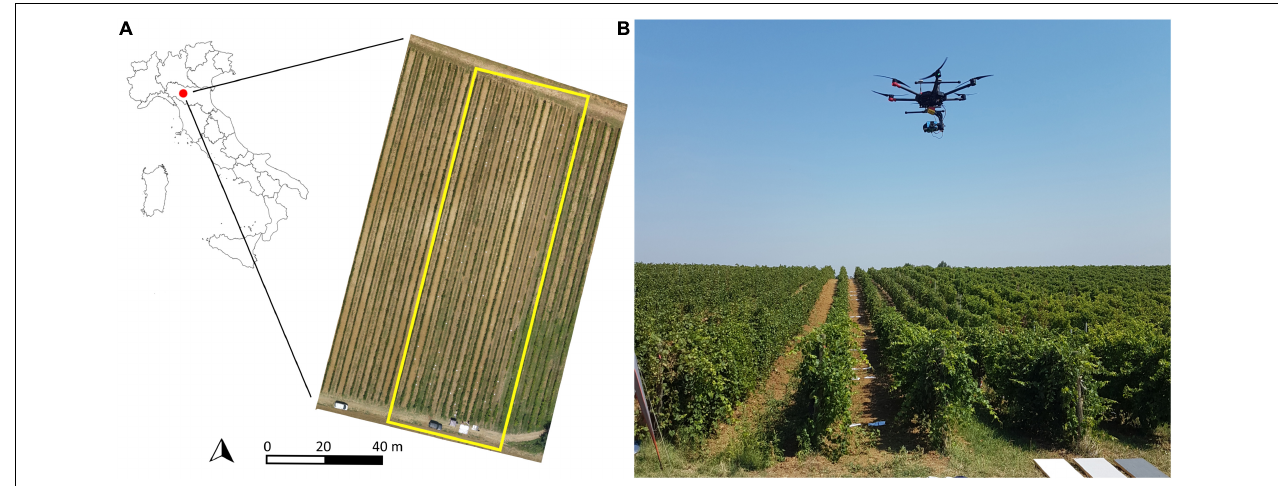
FIGURE 2 | Location of the experimental vineyard (A) and the Unmanned Aerial System used in the study (B) .